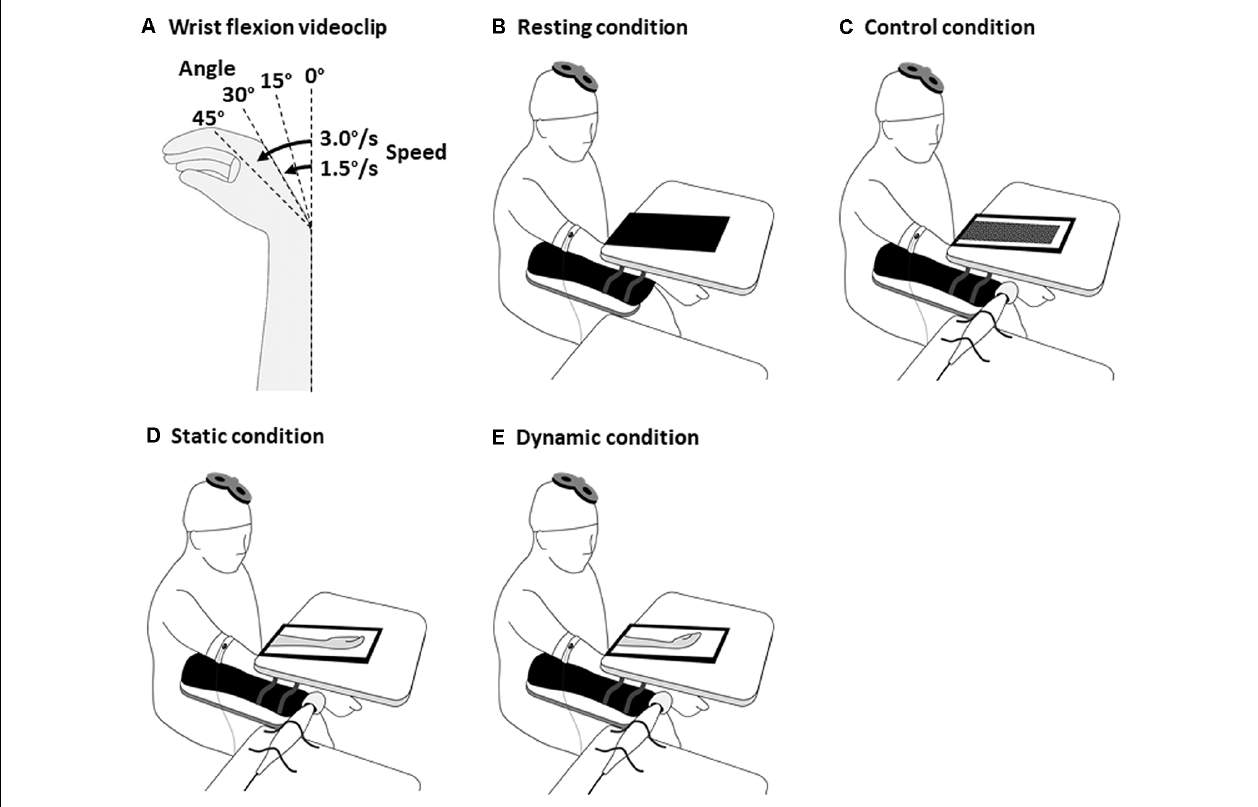
FIGURE 1 | Experimental design for the tasks with visuo-proprioceptive information difference. The wrist flexion videoclips (A) , the resting condition (B) involved showing a black screen, the control condition (C) , a mosaic patterned static videoclip; the static condition (D) , a static videoclip of wrist flexion 0 ◦ ; and the dynamic condition (E) , a videoclip that corresponded to each participant’s closely-matched wrist flexion angle and speed. The participants were instructed to fully relax their muscles. In the control, static, and dynamic conditions, the distal tendon of the dominant right ECR was stimulated by a tendon vibrator. Transcranial magnetic stimulation (TMS) was delivered to the primary motor cortex at the end of the vibratory stimulation. ECR, extensor carpi